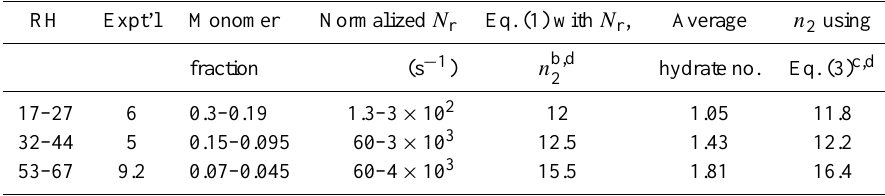
Table 3. H 2 O Power Dependency Treatments due to H 2 SO 4 hydration a . RH Expt’l Monomer Normalized N r Eq. (1) with N r , Average n 2 using fraction (s − 1 ) n b,d hydrate no. 2